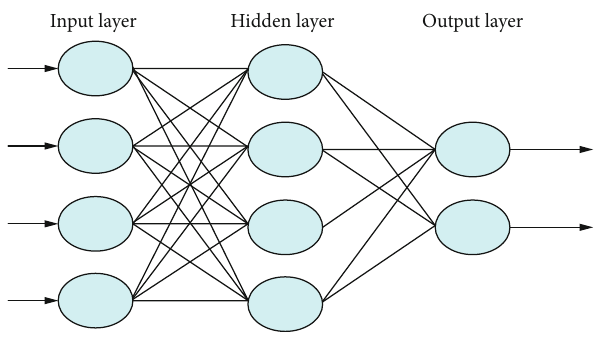
Figure 4: Neural network classi fi er.